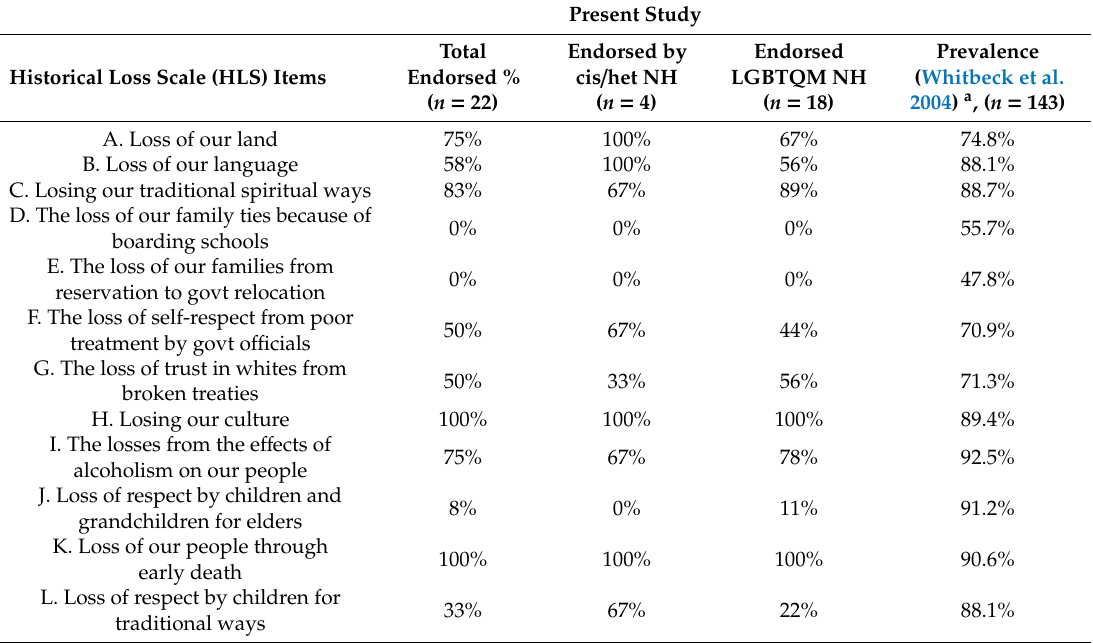
Table 1. HLS Item Prevalence: Historical Loss Scale items endorsed by Native Hawaiians (NH) compared to baseline prevalence among American